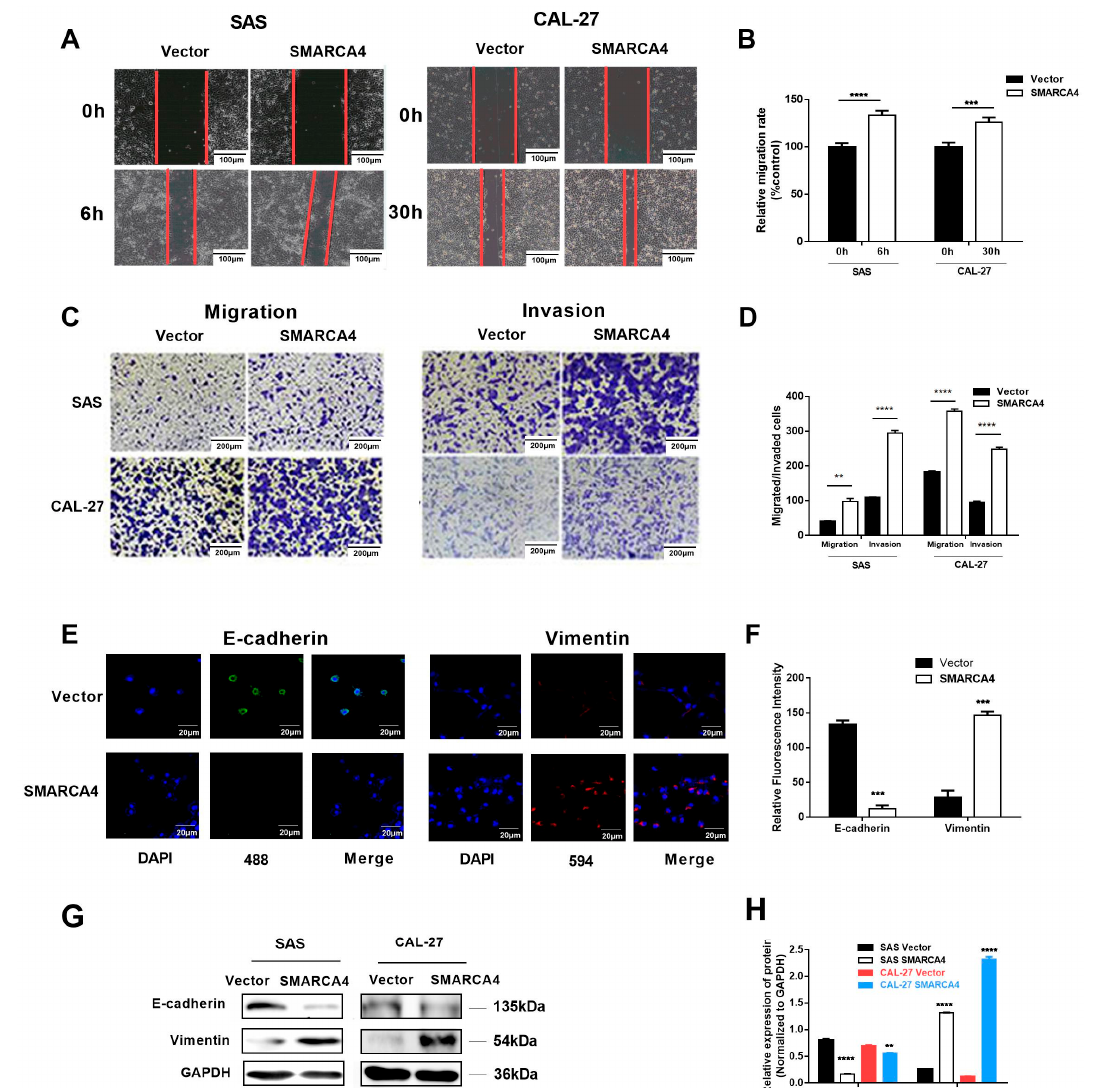
Figure 2. SMARCA4 promotes OSCC cell migration and invasion. ( A , B ) The effect of SMARCA4 overexpression on OSCC cell migration. SAS or CAL-27 cells were transfected with SMARCA4 overexpression plasmid or control vector for the indicated times (6 h for SAS, 30 h for CAL-27), and cell migration was assessed by the wound healing assay. Scale bar: 100 µ m ( A ). Quantitative analysis was performed using the Image J version 1.48 software ( B ). ( C , D ) The effect of SMARCA4 overexpression on OSCC cell migration and invasion. SAS or CAL-27 cells were transfected with SMARCA4 overexpression plasmid or control vector for the indicated times (24 h for SAS, 48 h for CAL-27). Cell migration and invasion were assessed by Transwell migration and invasion assays. Scale bar: 200 µ m ( C ). Quantitative analysis was performed using the Image J software ( D ). ( E , F ) Representative images of E-cadherin and vimentin expression in SAS cells detected by immunofluorescence staining after SAS cells were transfected with SMARCA4 overexpression plasmid or control vector for 48 h (Scale bar: 20 µ m, green represents E-cadherin, red represents vimentin, and nucleus is shown in blue by DAPI staining). ( G ) The effect of SMARCA4 overexpression on OSCC cell E-cadherin and vimentin protein expression levels. SAS and CAL-27 cells were transfected with SMARCA4 overexpression plasmid or control vector for 48 h, and the E-cadherin or vimentin protein expression levels were measured by Western blot analysis. ( H ) Quantitative analysis was performed using the Image J software. Data are expressed as the mean ± SEM from triplicate experiments. ** p < 0.01, *** p < 0.001, **** p < 0.0001 vs control vector